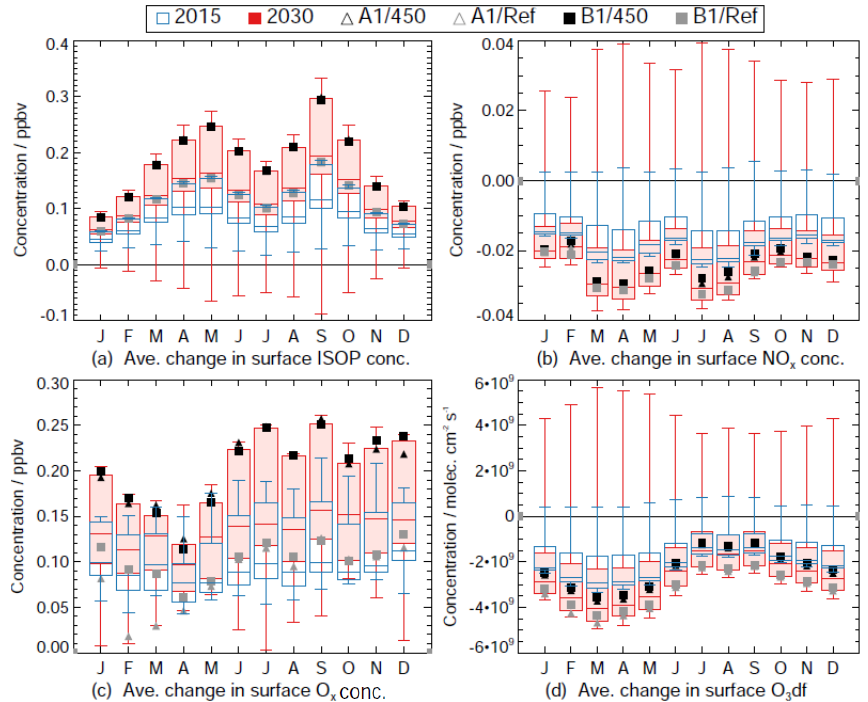
Fig. 10. Same as Fig. 7 but for India (Fig.